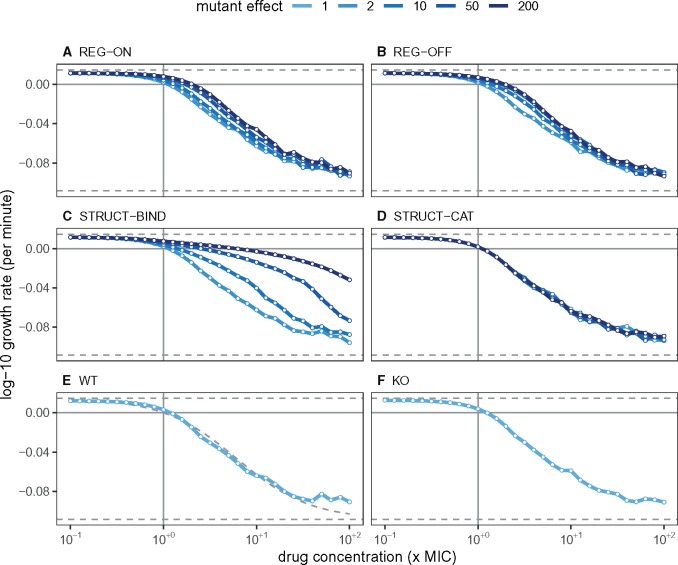
Population growth rates during the 3 h of antibiotic exposure. For each mutant class and effect level, we simulated a population of up to 100,000 cells, and recorded the number of live cells at 10-min intervals. From the corresponding time-kill curves (shown in supplementary fig. S7, Supplementary Material online), we extracted the net growth rate as the linear regression coefficient between the base-10 logarithm of cell number and the sample time, as described by Regoes et al. (2004). Horizontal dashed lines are the maximum and minimum growth rates, ψmax and ψmin. (A–D) regulatory and structural mutants; (E and F) WT and KO are included as controls. The dashed curve in panel (E) is the dose–response curve from Regoes et al. (2004).